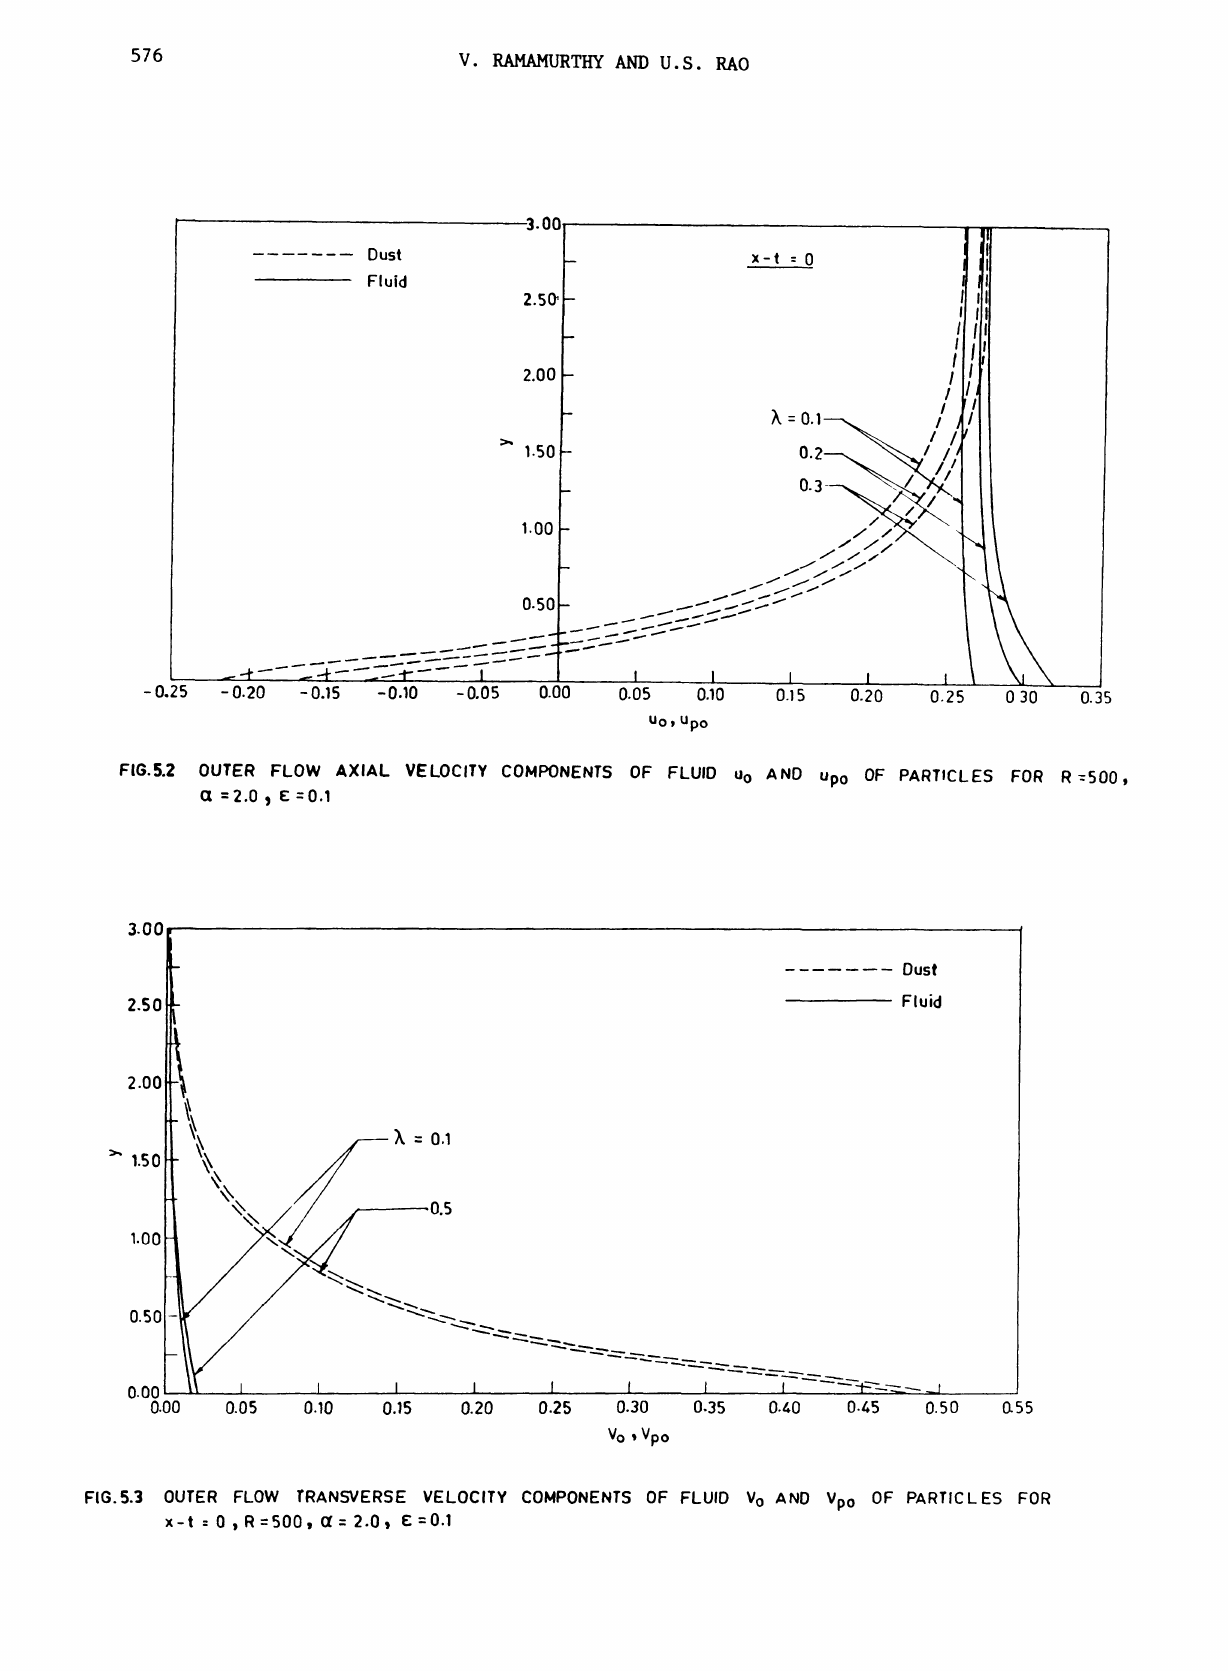
FIG.5.2 OUTER FLOW AXIAL VELOCITY COMPONENTS OF FLUID u o AND Upo OF PARTICLES FOR R=500, C =2.0 E =0.1